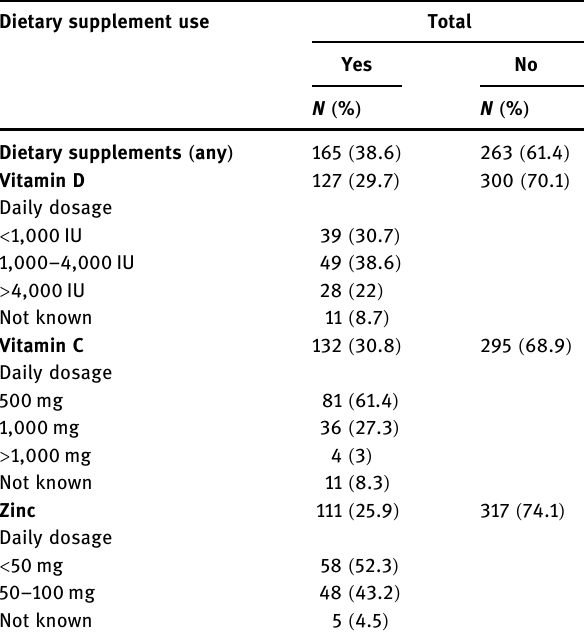
Table 5: Rate of receiving prophylactic dietary supplements and daily dosage in the studied participants